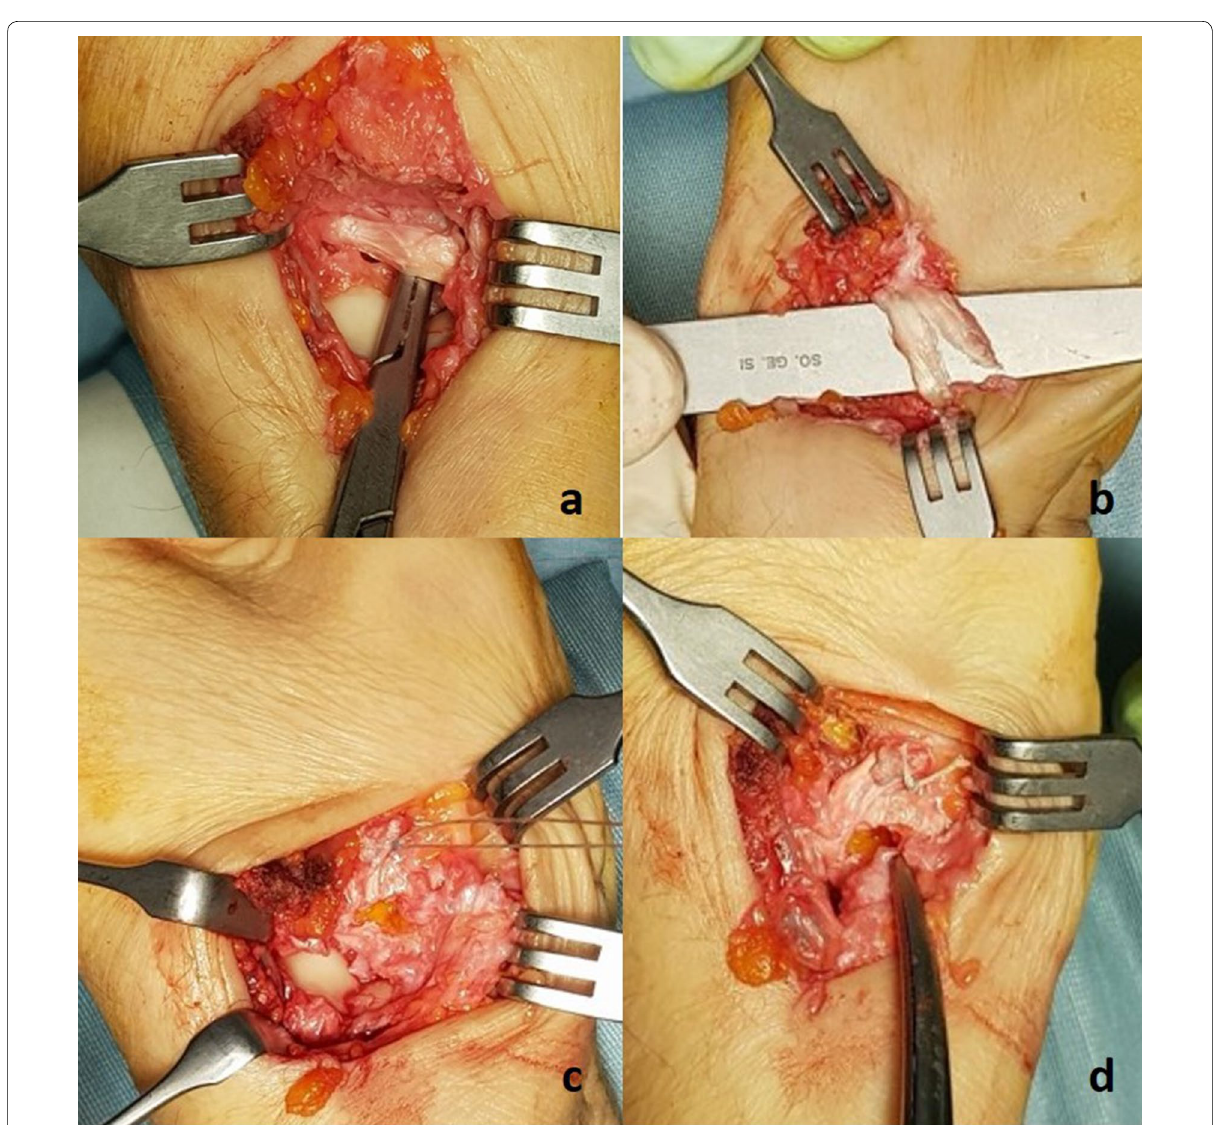
Fig. 1 a The flexor carpi radialis tendon is found on the bottom of the surgical approach after trapeziectomy. b A distally pedicled tendon graft is obtained by splitting the tendon lengthwise into two parts. c , d The tendon graft is inserted into the base of the first metacarpal to avoid its proximal migration, using a mini